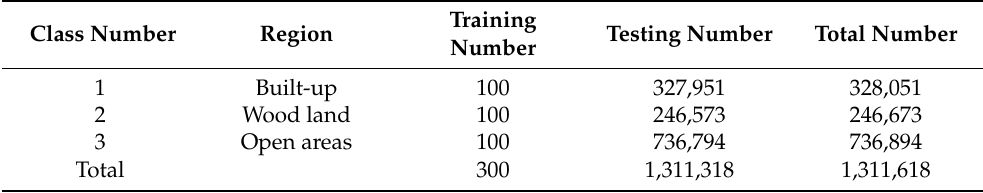
Table 3. Training and testing samples of the Oberpfaffenhofen